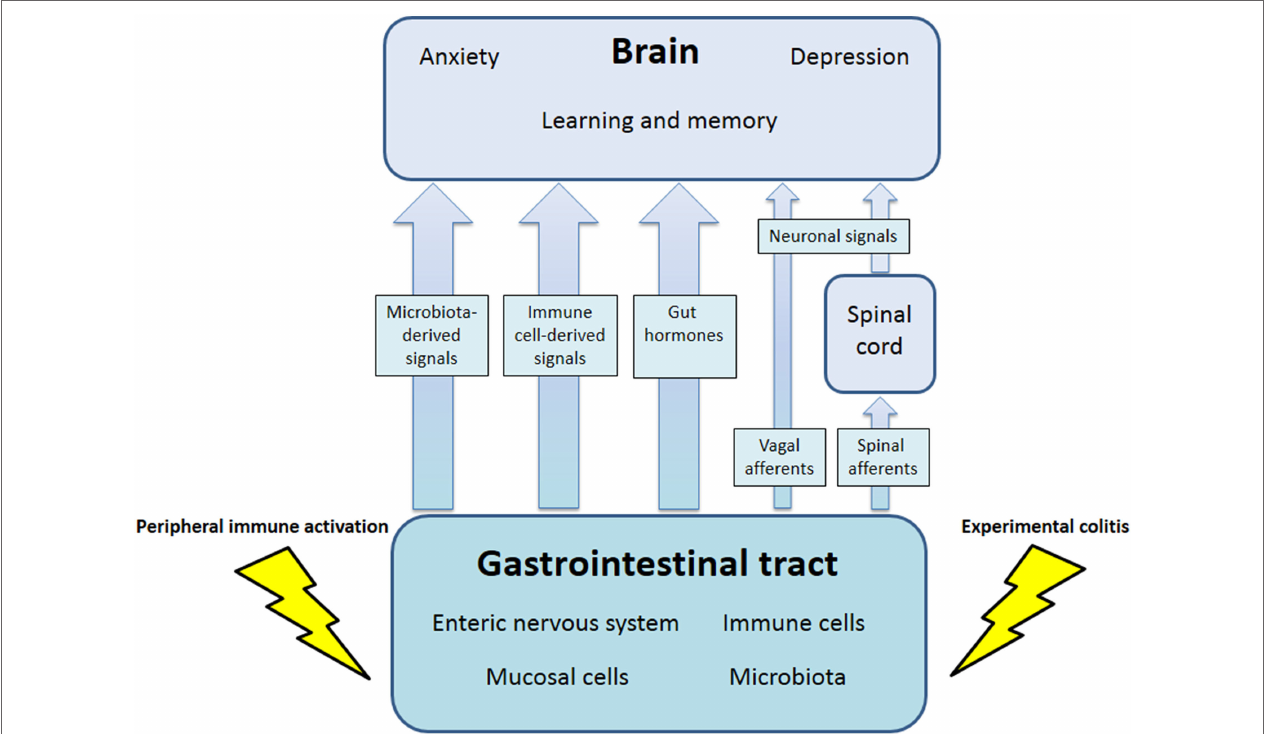
FiGURe 1 | Pathways involved in the behavioral disturbances associated with visceral immune activation and inflammation. There are multiple communication pathways between gut and brain: microbiota-derived signals, immune cell-derived signals, gut hormones, and vagal and spinal afferents. In the course of experimental colitis or microbe-evoked peripheral immune activation, signaling along these pathways is altered, ultimately influencing brain functions, such as anxiety, depression-like behavior, learning, and